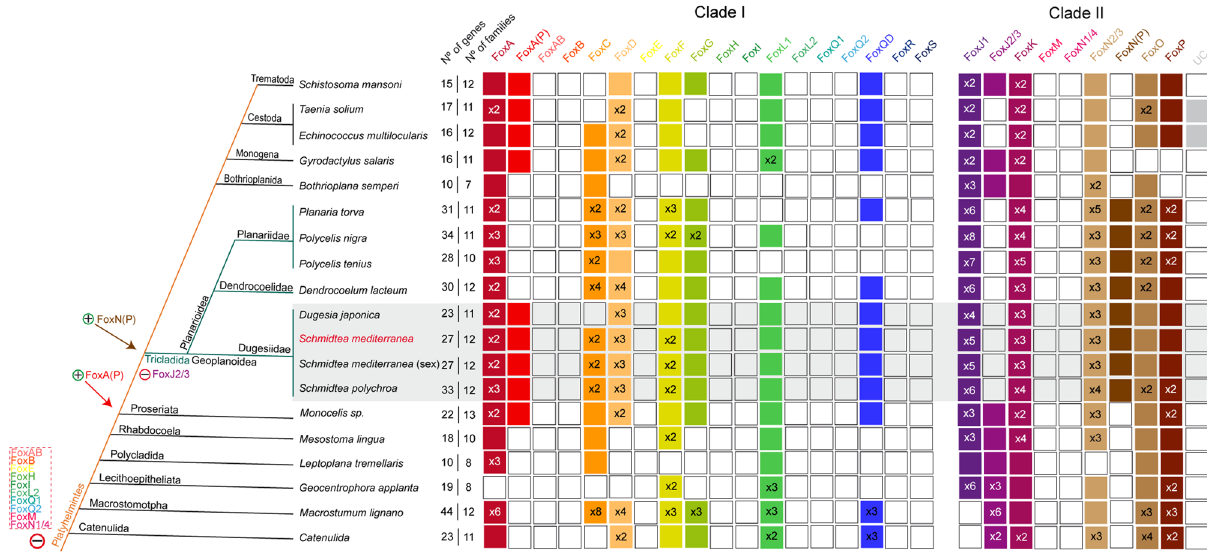
Figure 4. Distribution of Fox homologs reveals huge family loss and gene diversification in Platyhelminthes. Coloured boxes indicate the presence of an ortholog based on the phylogenetic analysis. When there were no evidences of ortholog, the box remained white. A number (x Nº) inside a box indicates paralogs per family and species. Families are divided in Clade I and II. Number of genes and number of families per species are indicated. Species were classified into Platyhelminthes and Tricladida phylogeny accordingly to 28 and 51 , respectively. Light orange indicates Platyhelminthes species within turquoise lines indicate Tricladida species; grey box indicates Dugesiidae family. Species belonging to the Tricladida order show different losses, gains and specialization events. Gains (+) and losses (−) of genes are indicated. Specifically, many families were lost in Platyhelminthes (red dashed polygon). FoxA(P) and FoxN(P) origin seems to predate Proseriata and Tricladida order,